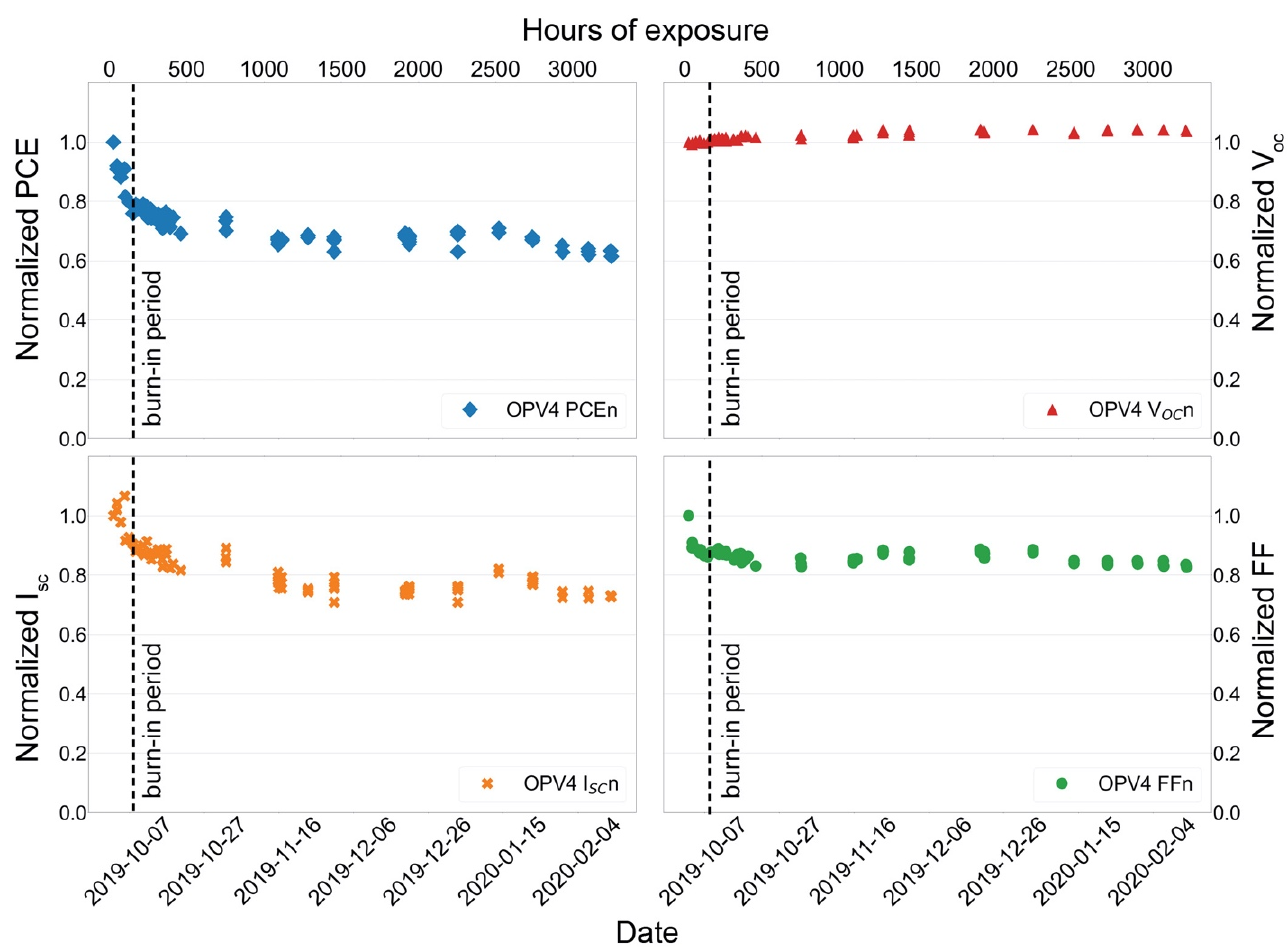
Figure 11. Normalized performance of OPV4 array at 600 ± 15 W m − 2 between 2 October 2019–16 February 2020, with dotted lines indicating the burn-in period.